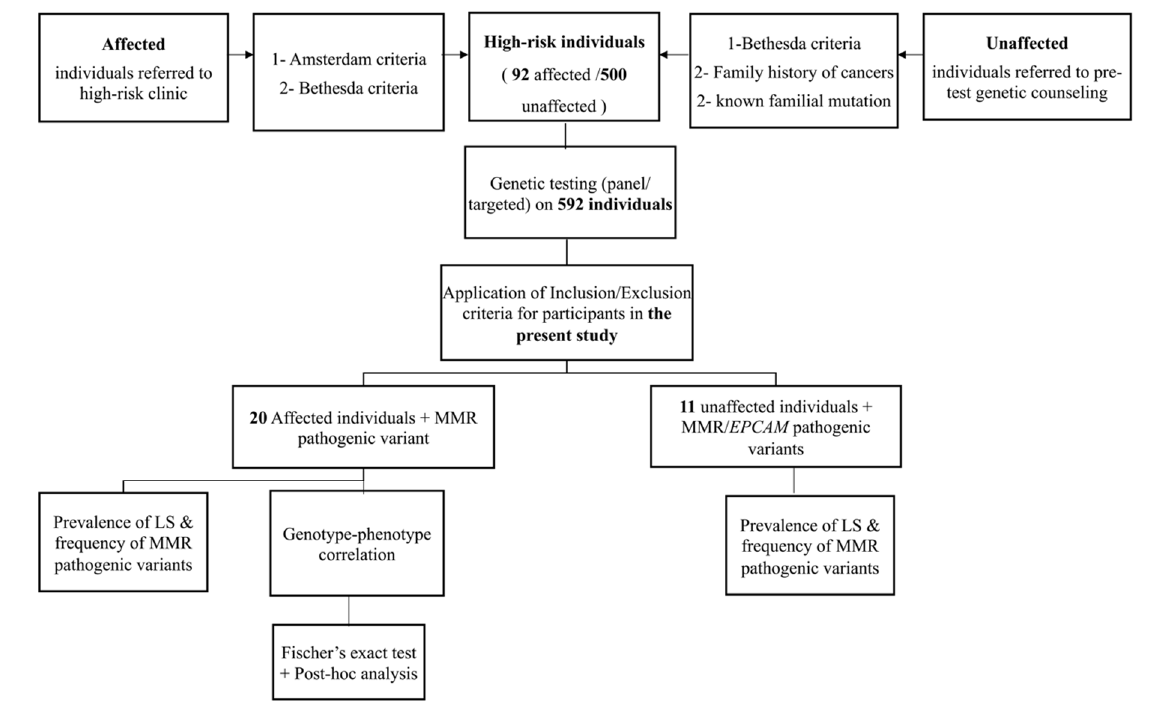
Figure 1. Flow chart of the study design. CRC: Colorectal Cancer. LS: Lynch Syndrome, MMR: Mismatch repair genes.